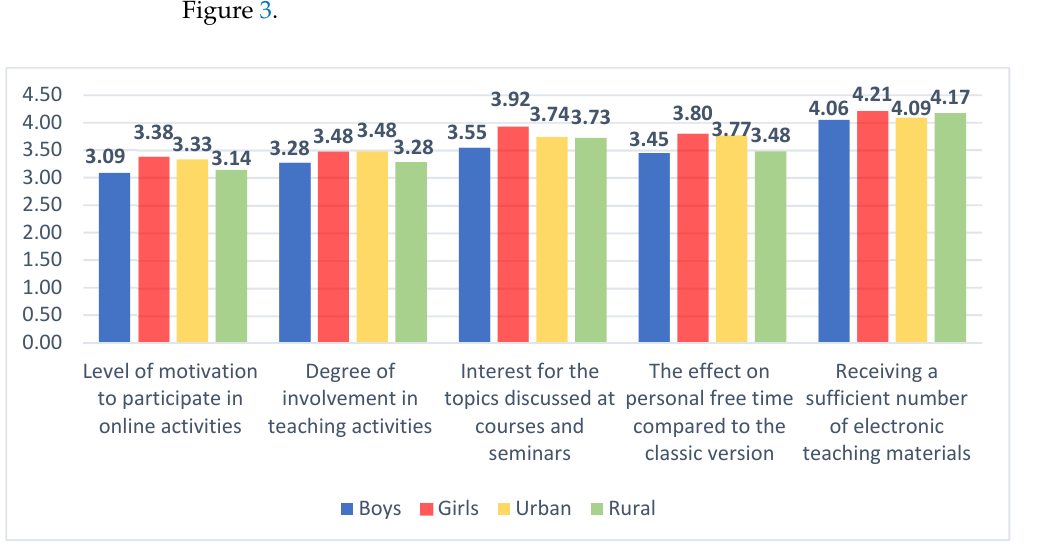
Table 10. The results of the questionnaire for the efficiency factor (univariate test).